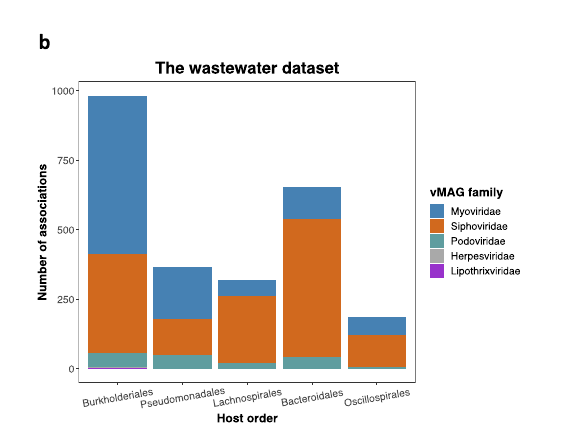
Fig. 5 | Taxonomy statistics of annotated vMAGs from real metagenomic Hi-C datasets. Taxonomy statistics of annotated vMAGs on the ( a ) human gut, ( b ) cow fecal,and ( c ) wastewater datasets. The numbers on the graph indicate the number